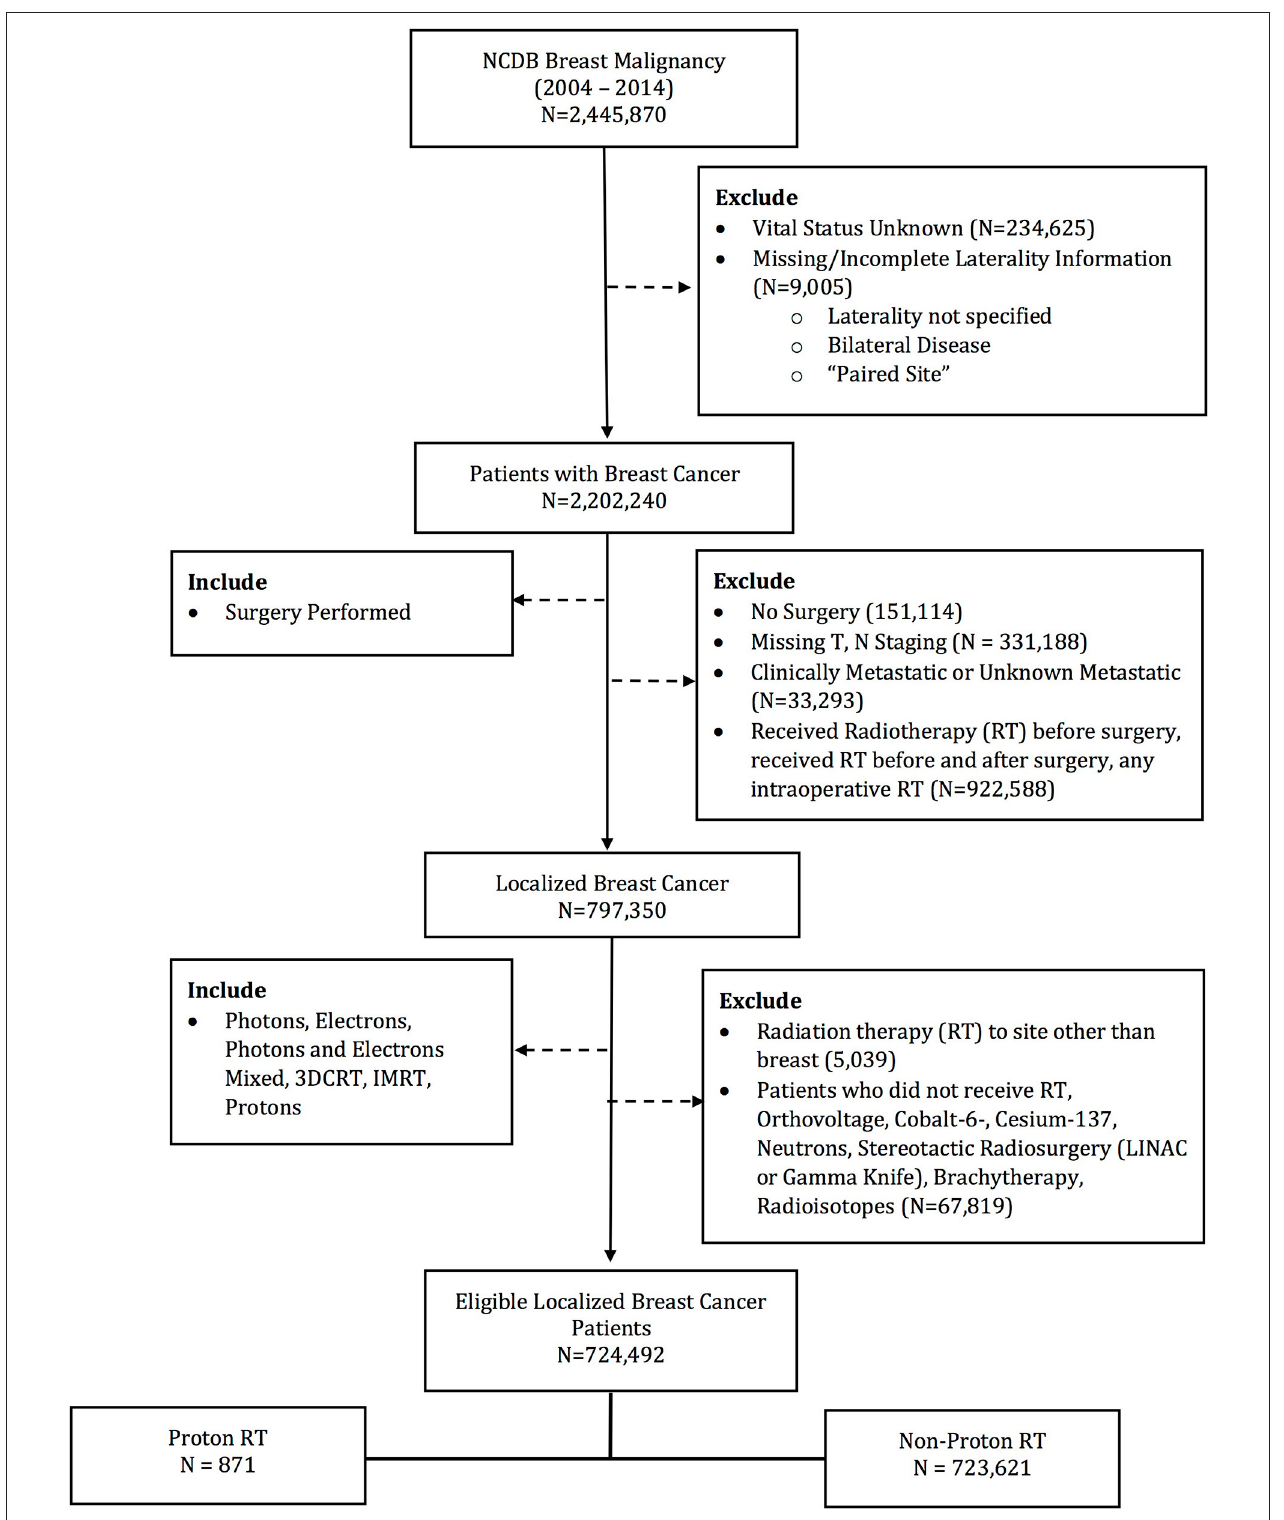
FIGURE 1 | Consort Diagram for selection of patient cohort.